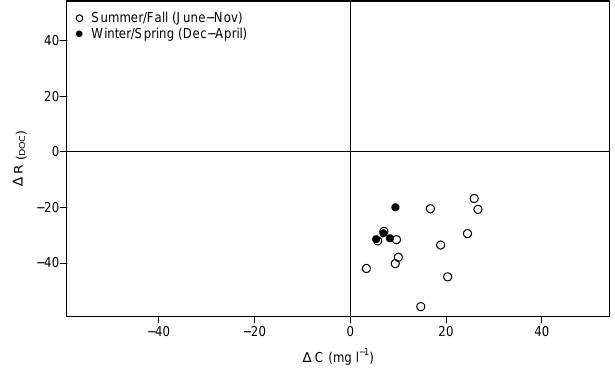
Fig. 2. Dynamics of DOC concentrations in runoff and riparian groundwater level in August 2010.